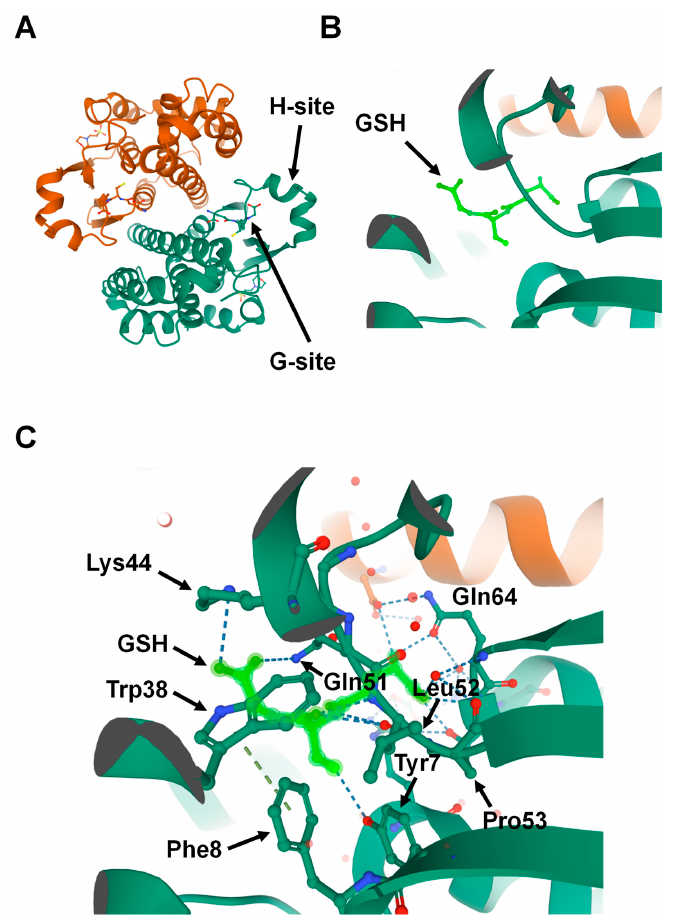
Figure 1. Structure of Glutathione S-transferase Pi 1 (GSTP1) (Protein Data Bank ID: 6GSS). ( A ) Homodimer assembly of GSTP1 showing G- and H-sites. ( B ) Magnified view of the G-site that is occupied by the ligand glutathione (GSH) (shown in light green). ( C ) Glutathione (light green) forms hydrogen-binding interactions with the surrounding amino acids found in the G-site pocket of GSTP1.